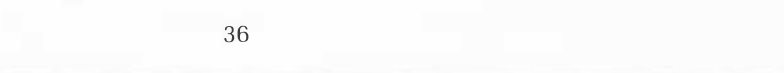
Figure 5 Iron cow (approximately 20cm high) from the royal regalia of the kingdom of